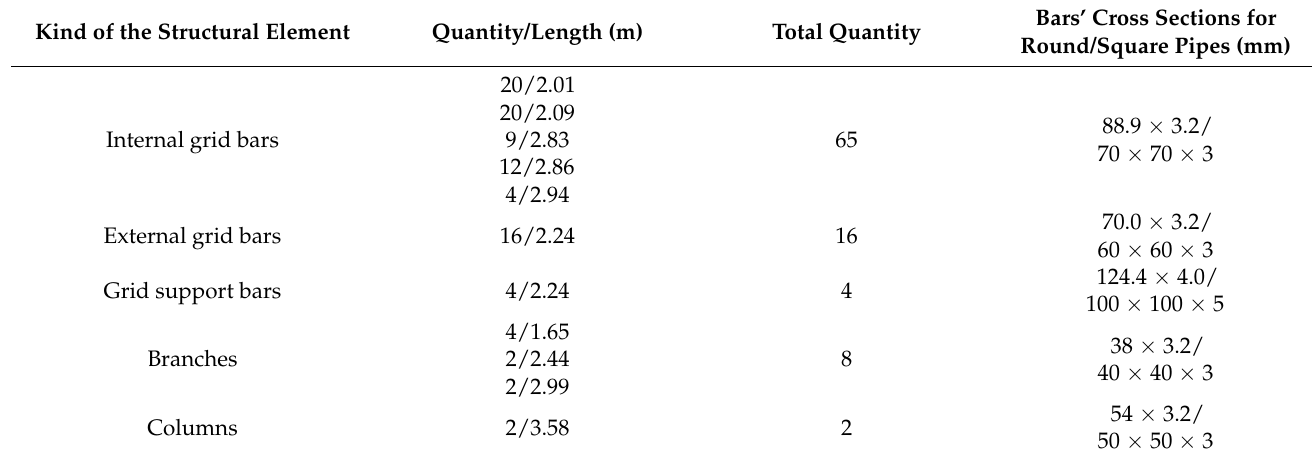
Table 5. The optimization results for the hyperbolic paraboloid canopy roof with the grid divided into five parts.